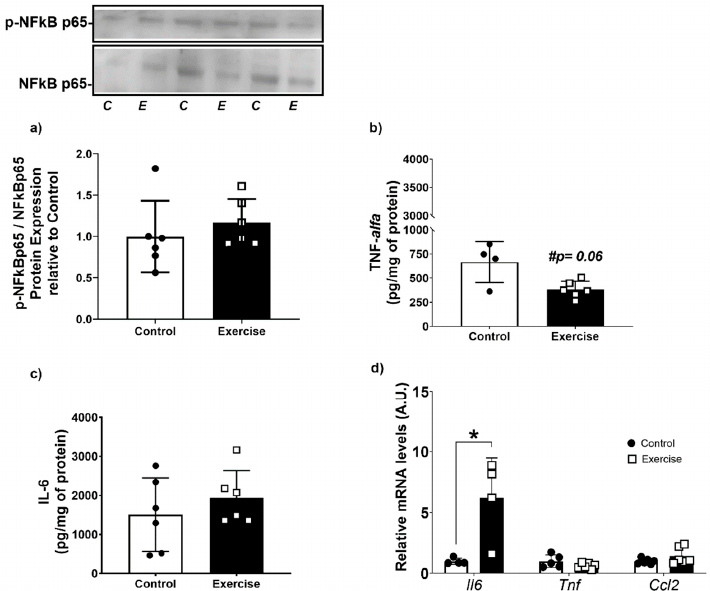
Figure 7. Aerobic exercise did not change inflammatory markers in WAT. ( a ) Nfkb-p65 phosphory- lation; ( b ) TNF-alfa cytokine levels; ( c ) IL-6 cytokine levels; ( d ) mRNA expression of genes related to inflammation; NFkB - p65 : Factor nuclear kappa B–subunit 65; Il6: Interleukin 6; Tnf: Tumors ne- crosis factor-alpha; Ccl2: CC motif chemokine ligand 2; The data were expressed as the mean ± standard error of the mean ( n = 6 animals/group). • -Control group; ▫ –Exercise group. # Statistical tendency = p < 0.06. * Statistical difference between groups.